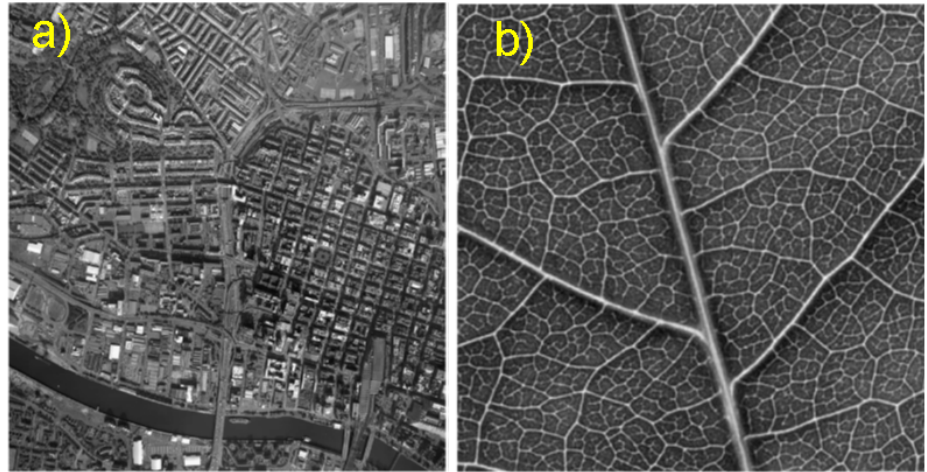
Figure 1. Examples of fractal-like structured networks in our environment, ( a ) an example of urban network (figure extracted from [30]) and ( b ), a natural network observed in a